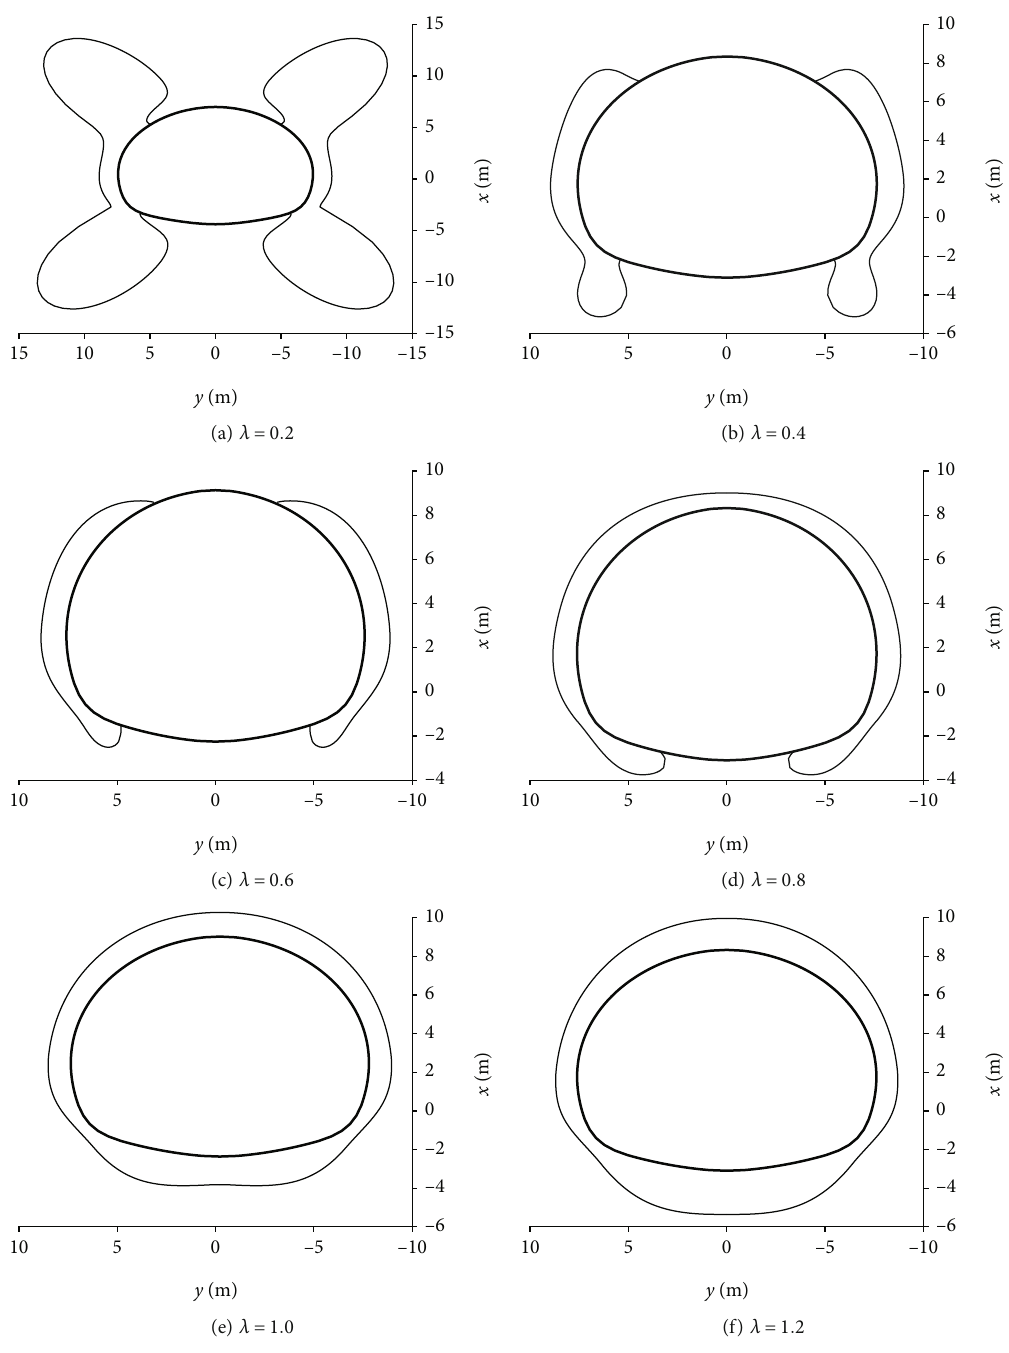
Figure 9: The plastic zone for di ff erent λ predicted by the analytical